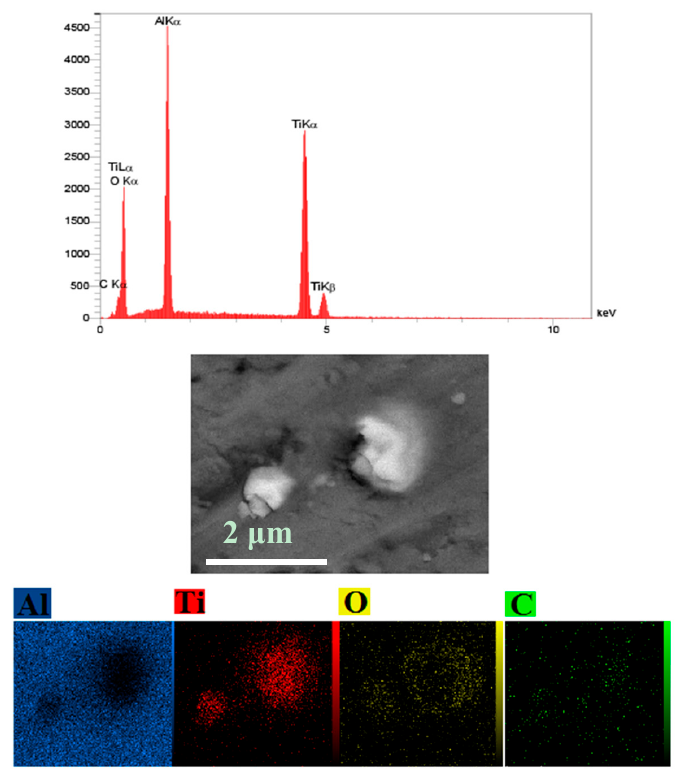
Figure 7. Backscattered and EDS elemental mapping of the microwave sintered sample.